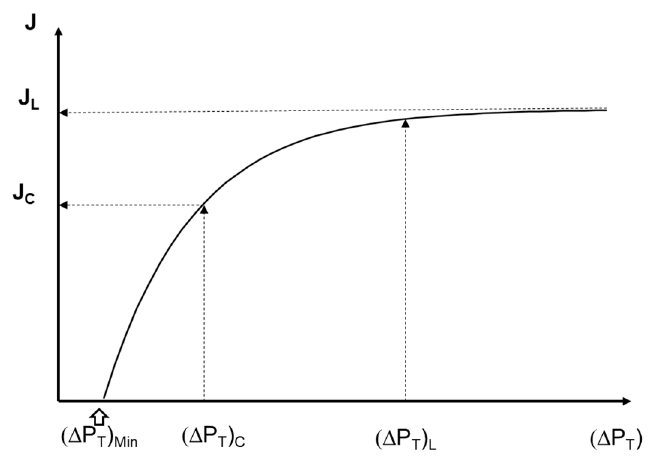
Figure 2. Generalized example of the graphical local of the parameter fitted by Equations (10)–(12).